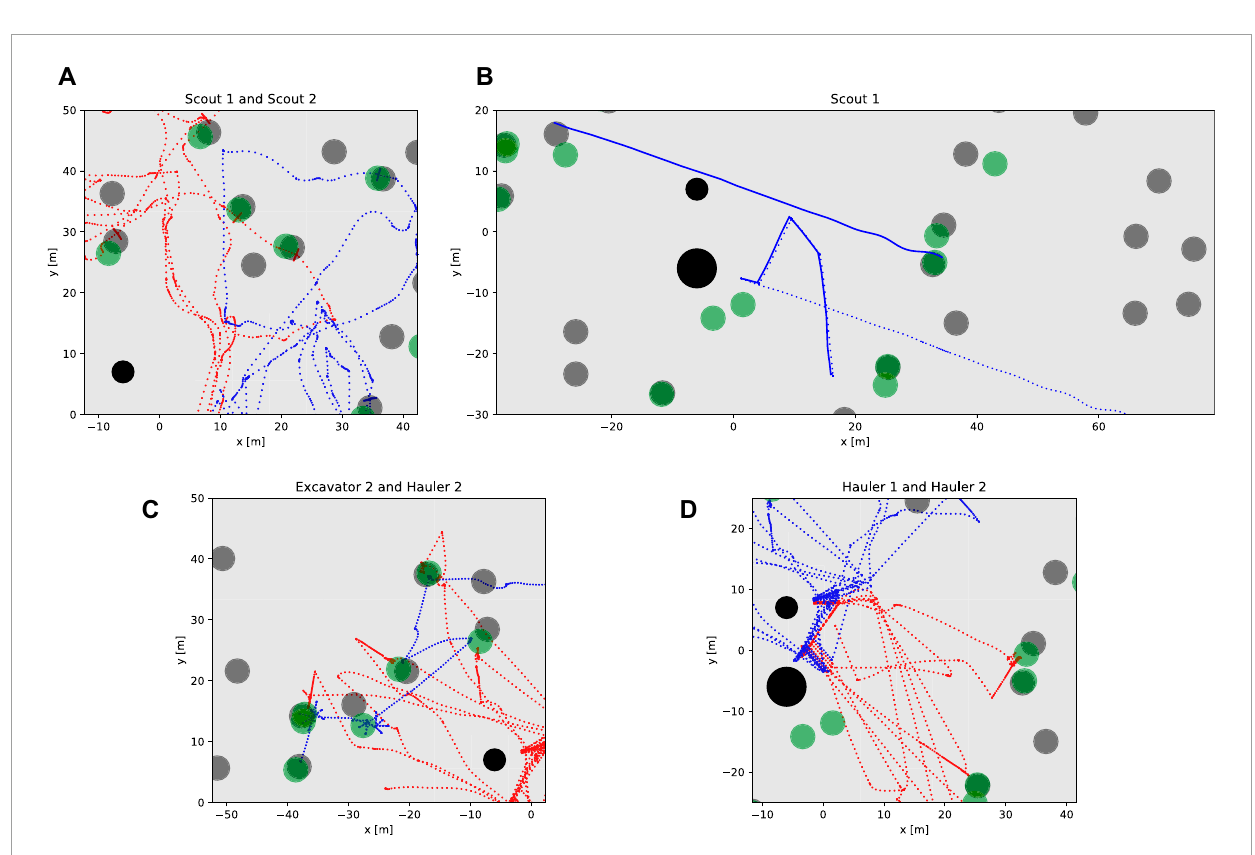
FIGURE 14 Rover operations in detail. The volatiles true position is shown in dark grey and the position recorded by the scouts is shown in green. (A) Volatile search and mapping for Scout 1 (blue) and Scout 2 (red). (B) True (dashed) and estimated (solid) trajectory for Scout 1 when it performs a homing update to correct its localization estimate. (C) Excavator (blue) and Hauler (red) visiting sites to excavate and transport resources. It is possible to see that the excavator had to use its 8-directions search at least twice to find volatiles. (D) Hauler dumping and fast